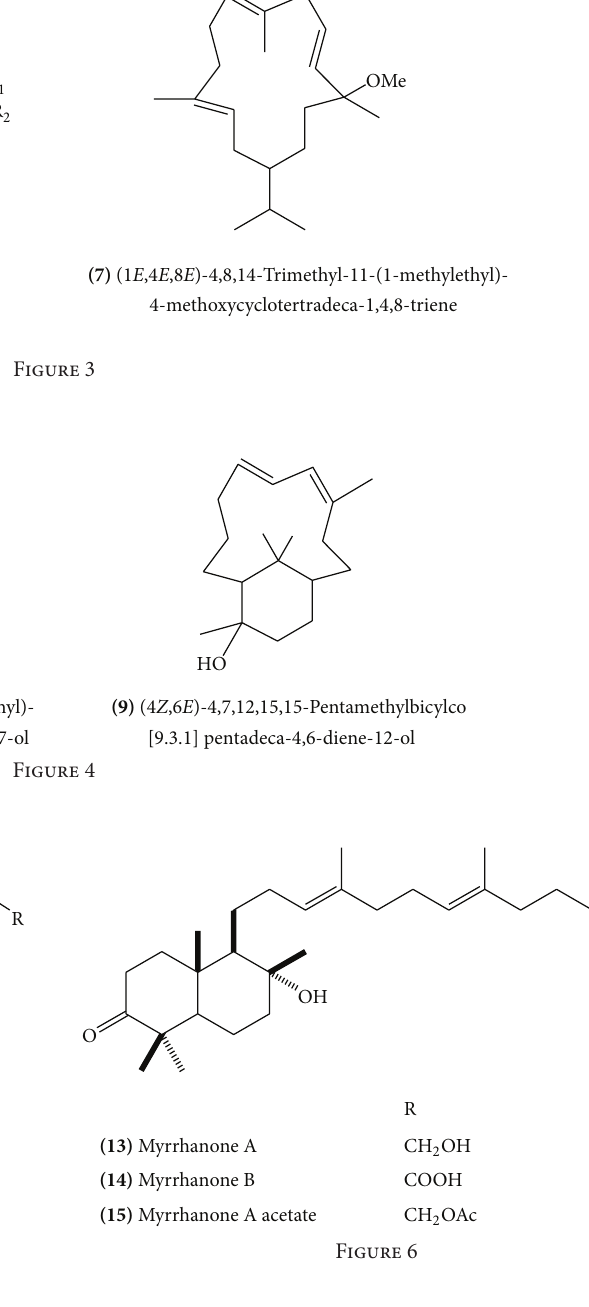
A myrrhanone derivative, (13𝐸, 17𝐸, 21𝐸) -8-hydroxypolyp- oda-13,17,21-trien-3-one (21) (Figure 10), and a myrrhanol derivative, (13𝐸, 17𝐸, 21𝐸) -polypoda-13,17,21-trien-3,18-diol (22) (Figure 10), have also been isolated